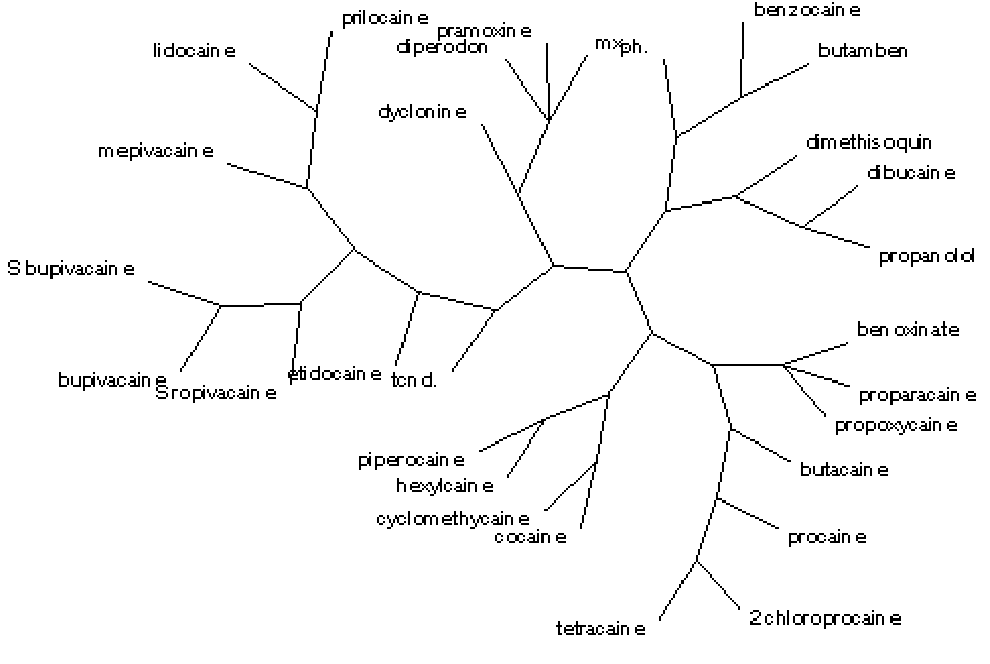
Figure 6. Radial tree for anaesthetics including physicochemical and pharmacological